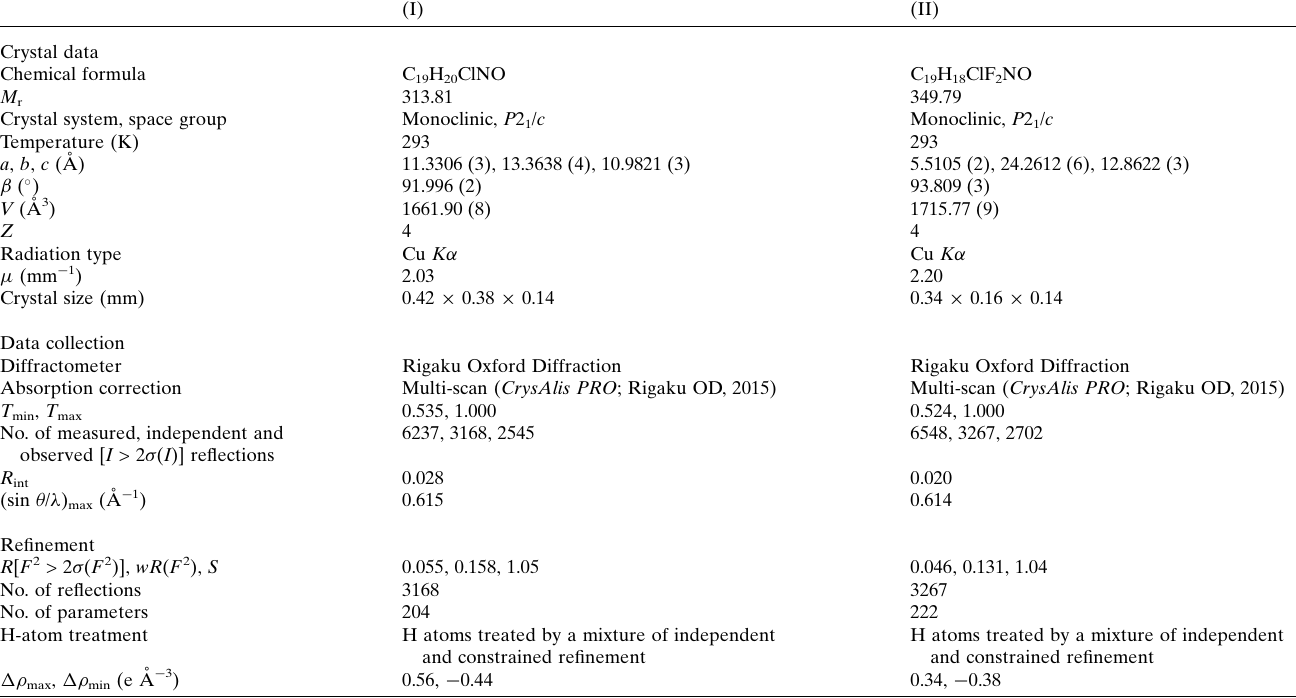
Table 3 Experimental details.